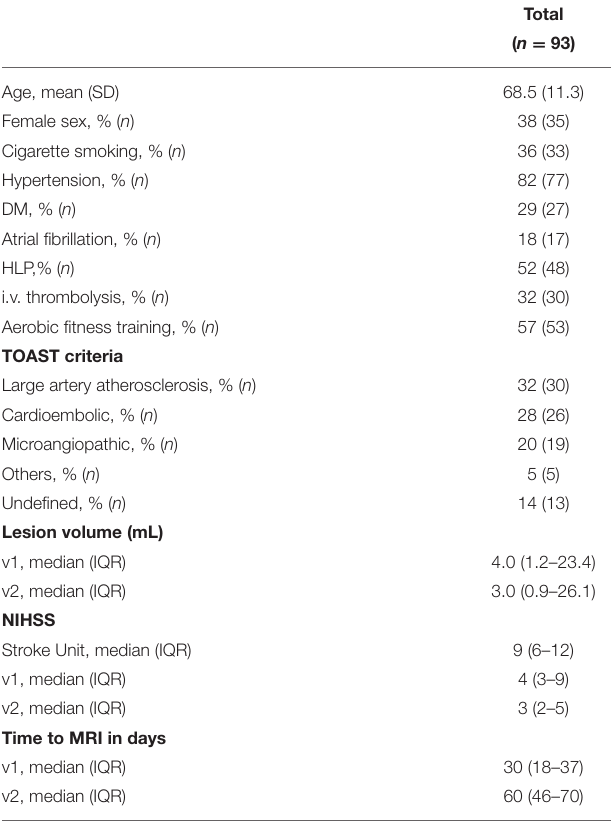
TABLE 1 | Patient demographics of the study